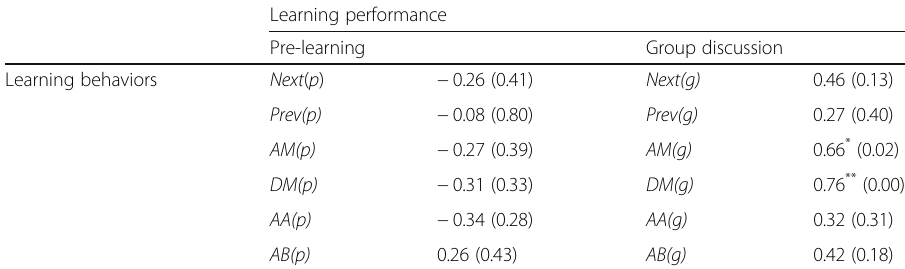
Table 4 Spearman ’ s rank correlation coefficients between learning performance and learning